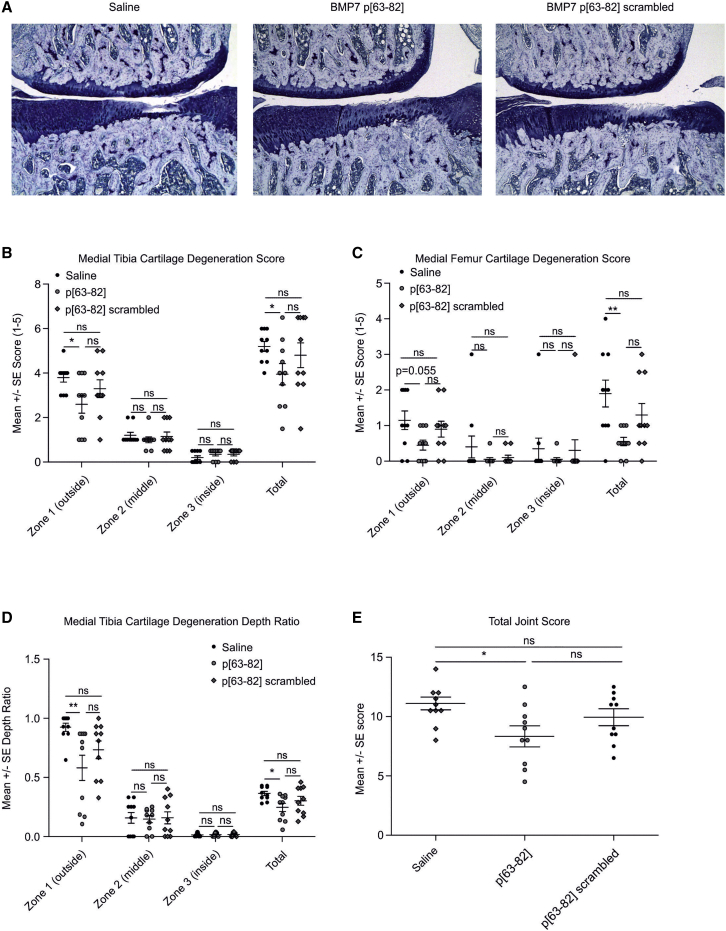
BMP7-derived peptide p[63−82] in rat MMT modelThe potency of BMP7 peptide p[63−82] to delay the progression of trauma-induced cartilage degeneration was tested in the rat MMT model. 1 week post-MMT-surgery, rats were two times per week intra-articularly injected with saline, 100 ng peptide p[63−82] in saline, or 100 ng scrambled peptide p[63−82] in saline (10 rats per group). All injection volumes were 50 μL. At 4 weeks post-MMT surgery, rats were sacrificed for histopathological scoring of the MMT knee joints. (A) Representative micrographs of toluidine blue-stained sections of medial aspects of the MMT knee joints. Conditions are indicated. (B) Medial tibia cartilage-degeneration scores. (C) Medial femur cartilage-degeneration scores. (D) Medial tibia cartilage-degeneration depth ratios. Scores and ratios are shown for zones 1, 2, and 3 individually.35 The total scores/ratio are cumulative for zone 1, 2, and 3. (E) Total joint scores. Individual data points represent individual rats. Error bars represent mean ± SEM. Statistical differences were calculated between groups (Mann-Whitney U test), and ∗p < 0.05, ∗∗p < 0.01, and ∗∗∗p < 0.001. Other data from this MMT experiment are shown in Figure S5.